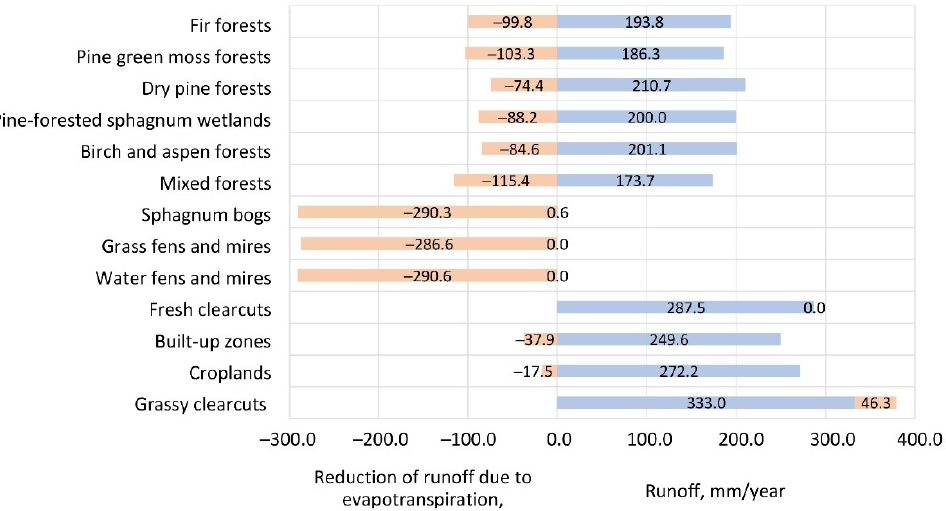
Figure 4. Contribution of different land-cover types to the ES of water yield regulation: actual runoff (blue bars) and reduction in runoff due to evapotranspiration (pink bars).